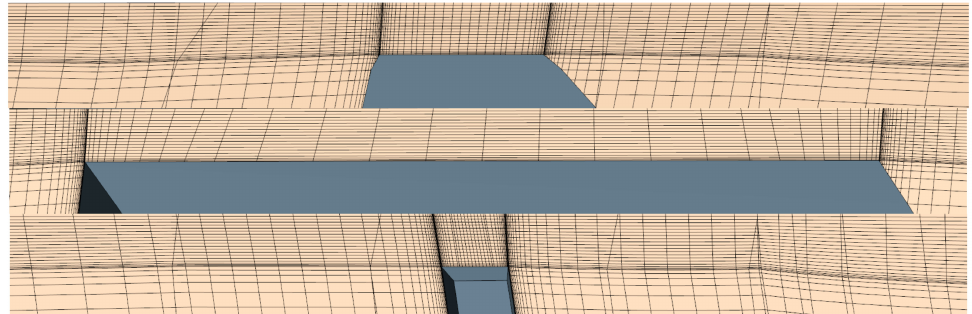
Figure 4. The grid structure in the tip clearance of a rotor. The sections perpendicular to the nose-tail chord of the tip are shown at 10% ( top ), 50% ( middle ), and 90% ( bottom ) chord length.